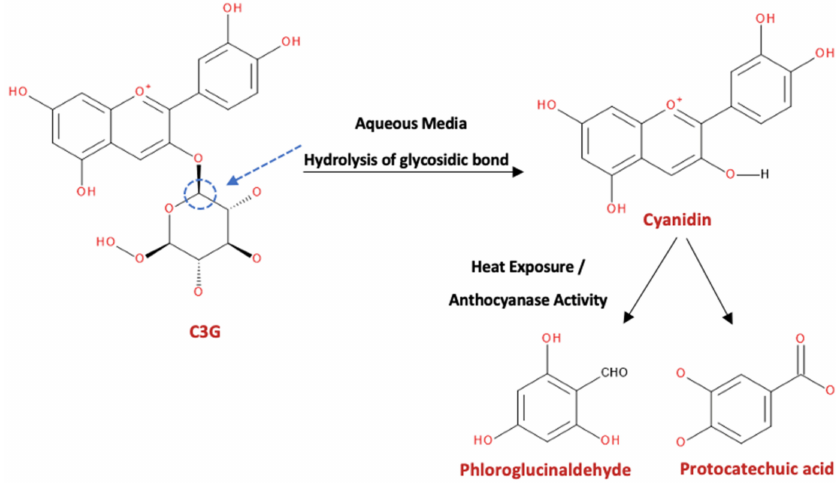
Figure 2. Degradation pathway of C3G according to Dai et al.